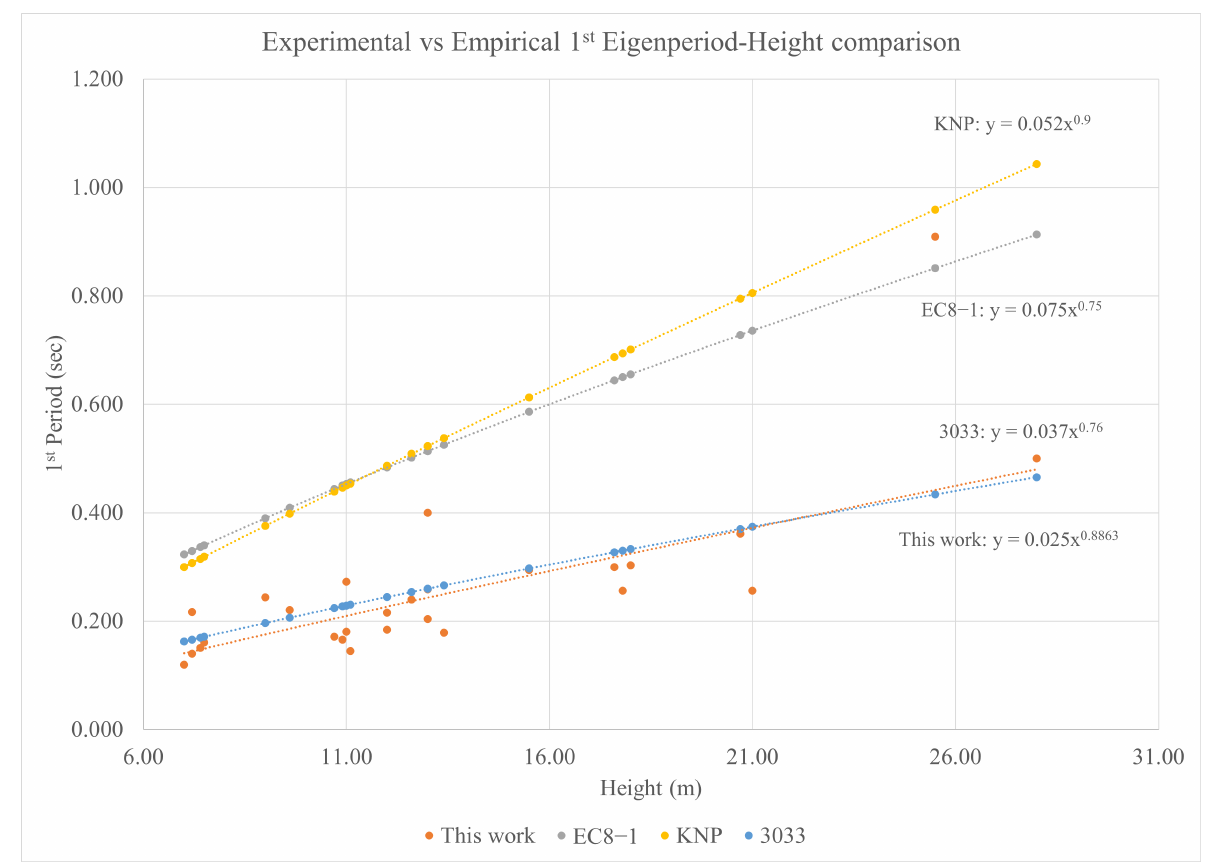
Figure A1. Experimental vs Empirical 1st Period-Height